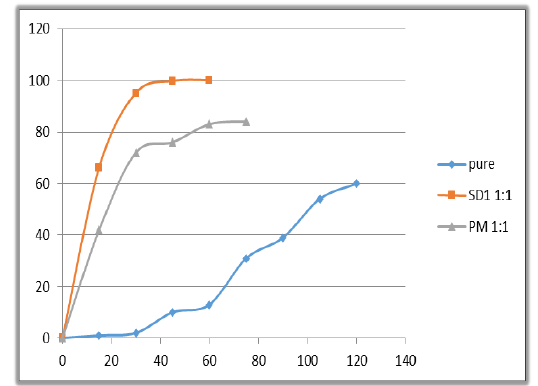
Figure 3. Comparative in-vitro dissolution profile of the pure MLX, SD1 and physical mixture of SD1 (PM) in phosphate buffer (pH7.5) at 37±0.5 °C Powder X-ray diffraction (PXRD)